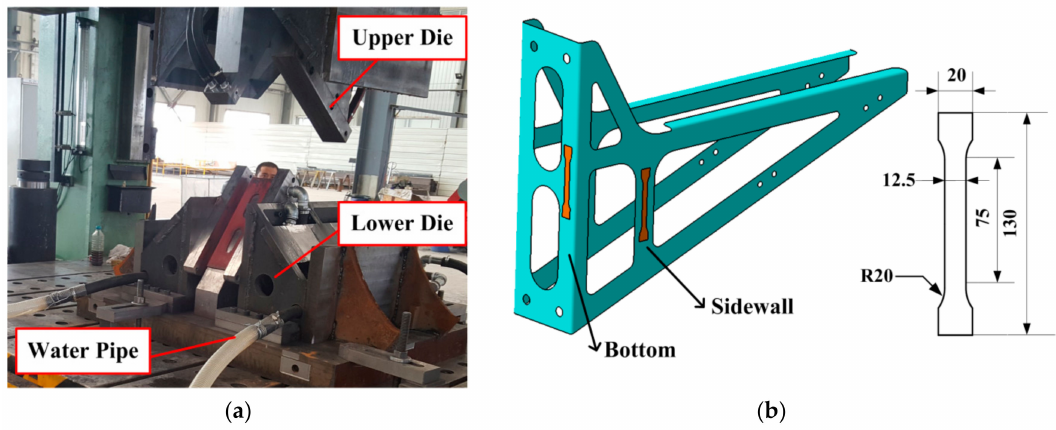
Figure 7. Hot stamping dies ( a ) the positions and the geometrical dimension of the specimens (mm) ( b